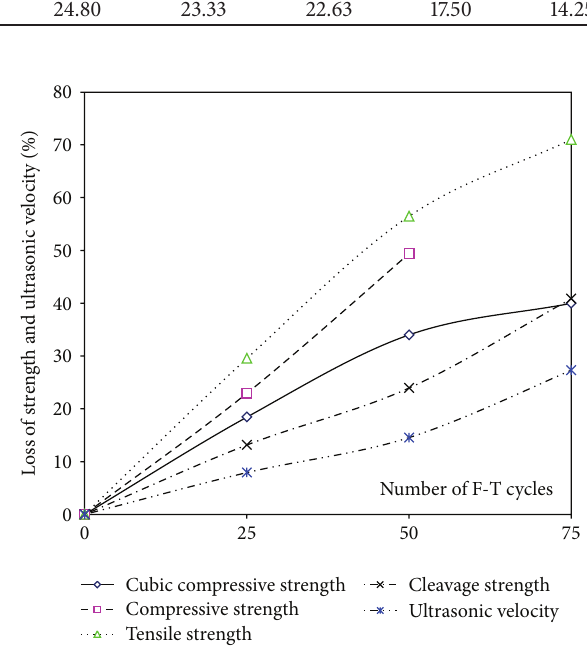
Figure 3: The loss of strength and ultrasonic velocity of plain concrete versus number of F-T cycles.